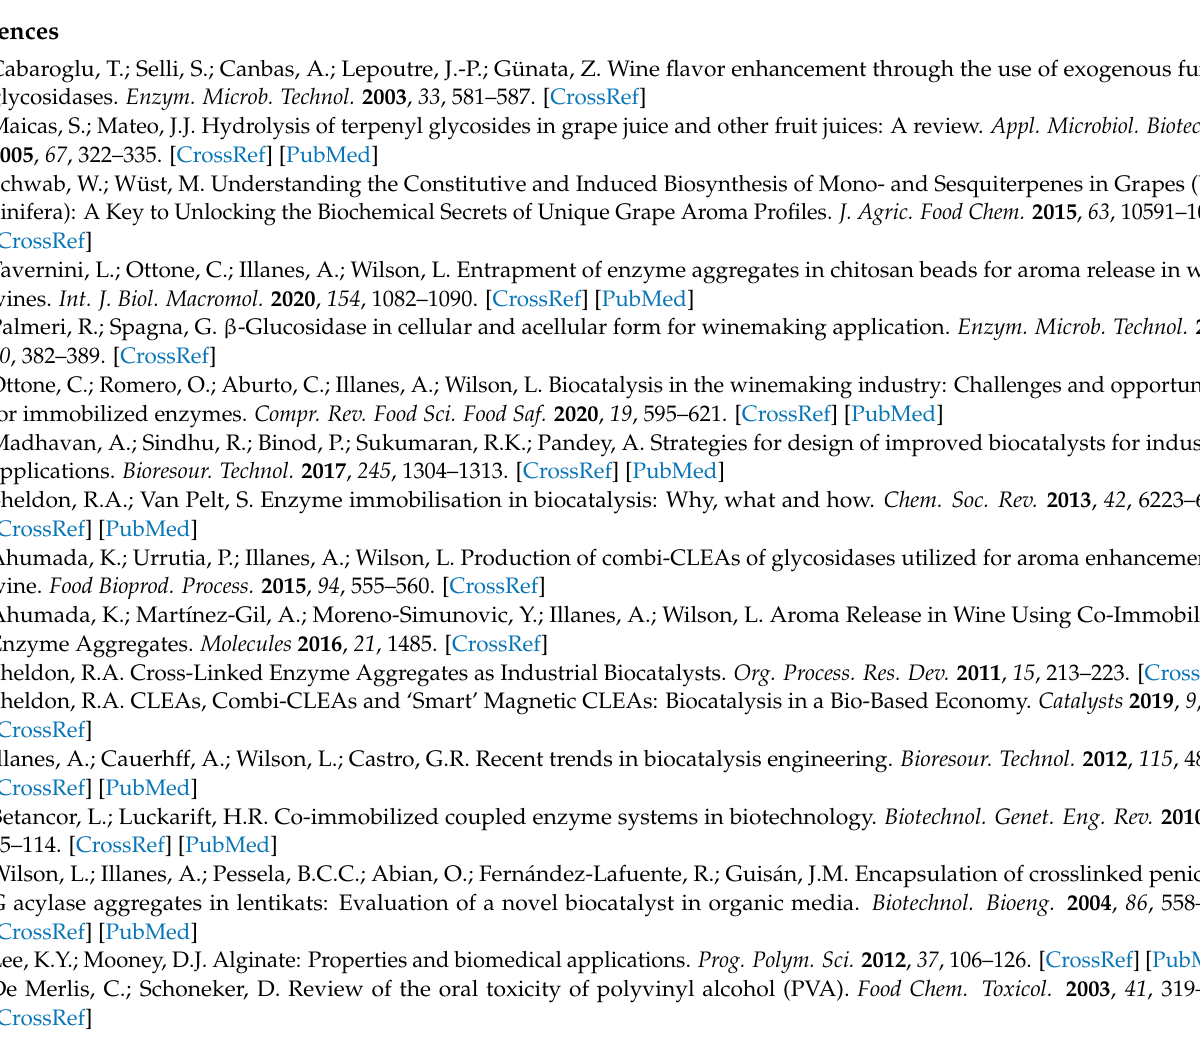
effects are shown in red font color. Table S11: Analysis of variance of the effect of loading (L) (mg combi-CLEA /g alginate ), and particle size (S) (mm) on the specific activity of β G, as a result of the encapsulation of combi-CLEAs of glycosidases polyvinyl alcohol lens-shaped particles. Replicates n = 2. Table S12: Analysis of variance of the effect of loading (L) (mg combi-CLEA /g alginate ), and particle size (S) (mm) on the specific activity of ARA, as a result of the encapsulation of combi-CLEAs of glycosidases polyvinyl alcohol lens-shaped particles. Replicates n =